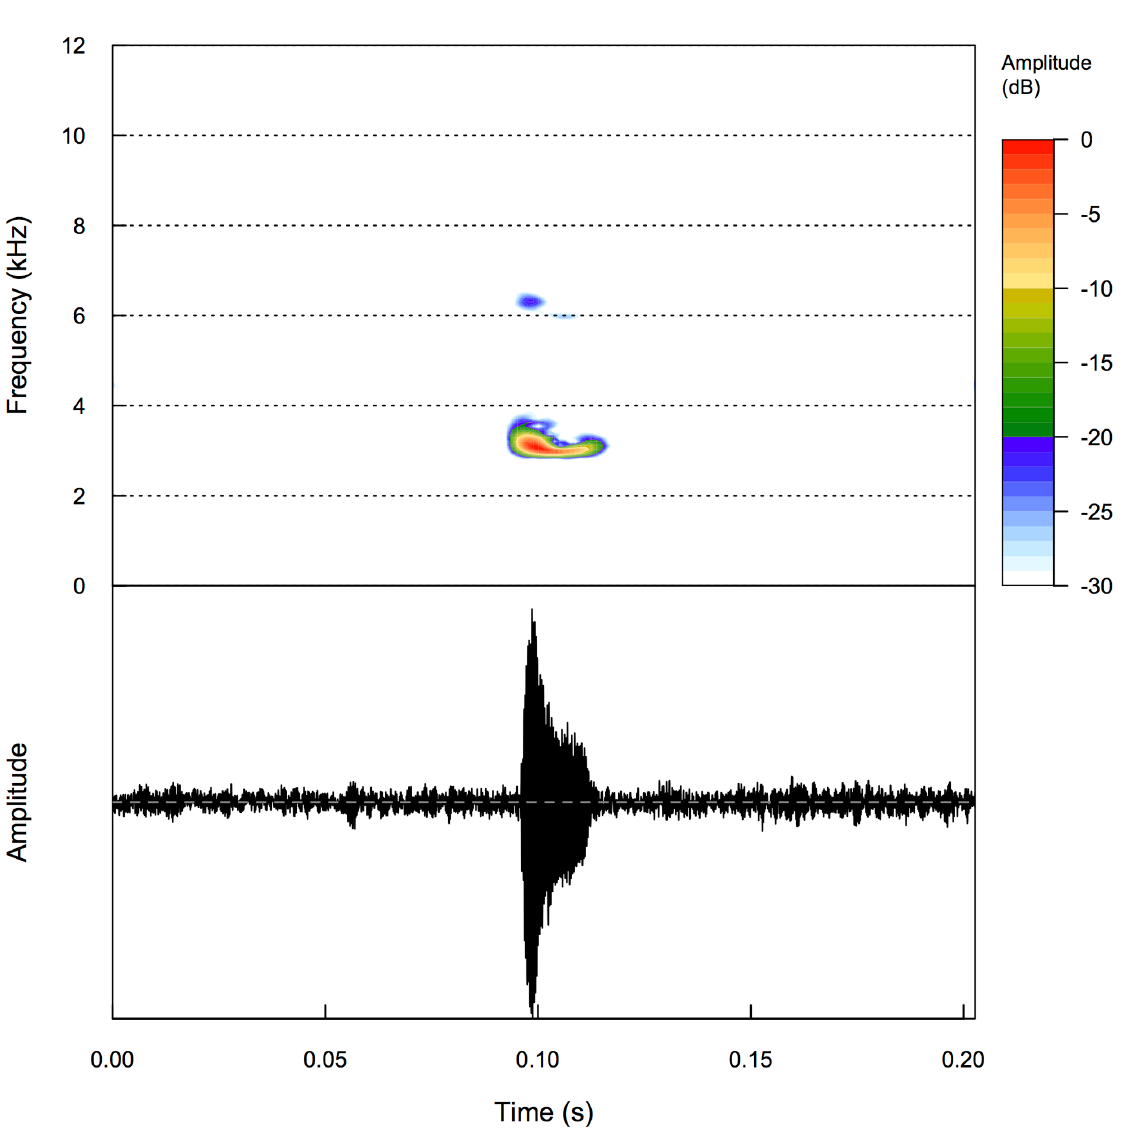
Fig. 8. Vocalization of Pristimantis marmoratus (Boulenger, 1900); oscillogram and spectrogram obtained using Seewave v. 1.6.4 in R. Spectrogram (top) and oscillogram (below) of one call of IRSNB 14472 from Kaieteur National Park, Guyana. Call recorded at a temperature